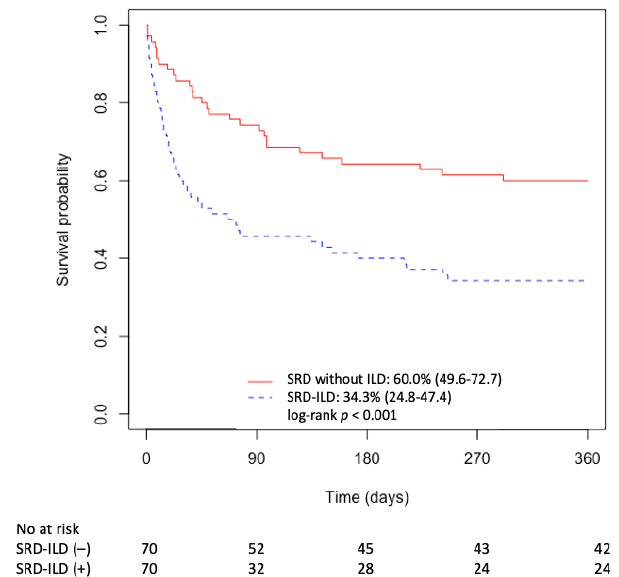
Figure 2. Comparison of Kaplan–Meier curves of one-year survival after ICU admission of SRD patients with (blue dashed line) and without interstitial lung disease (red line). Control group of critically ill SRD patients without ILD matched on the basis of age, sex, Charlson index, SOFA score, SRD type, and/or level of immunosuppression. ICU = intensive care unit, ILD = interstitial lung disease, SRD = systemic rheumatic diseases. Table 3. Comparison to the control group (SRD patients without ILD).